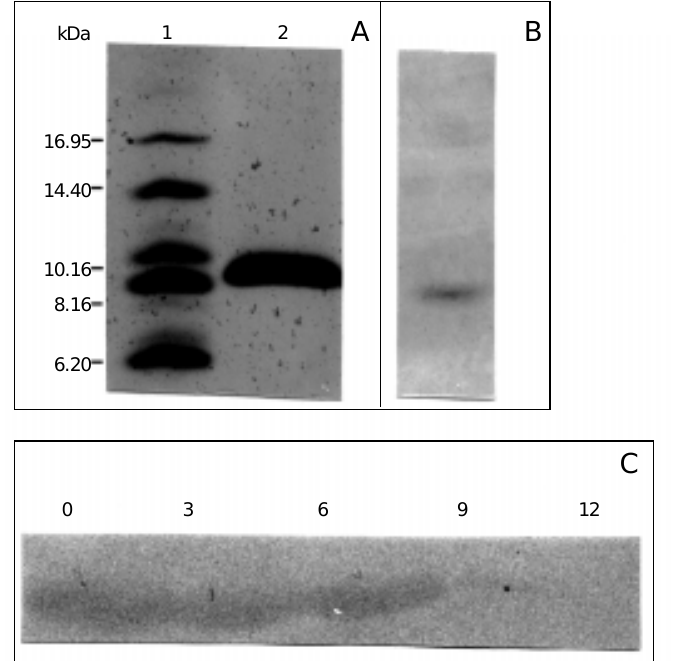
Figure 1 - A , Assessment of the homogeneity of the methionine-rich protein isolated from the seeds of C. jamacaru by SDS-PAGE. Purified protein (4 µg) was added to lane 2 and molecular weight markers were applied to lane 1. B , Assessment of the homogeneity of the methionine-rich protein isolated from the seeds of C. jamacaru by isoelectric focusing. C , Western blot analysis of the mobilization during germination of the methionine-rich protein isolated from the seeds of C. jamacaru . The samples analyzed were prepared from seeds 0, 3, 6, 9 and 12 days